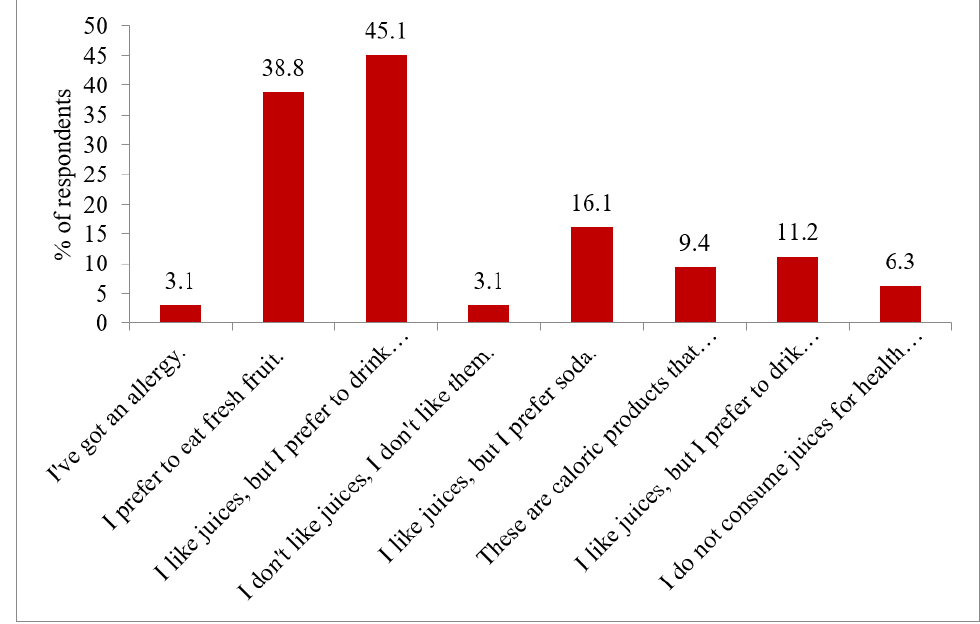
Figure 2. Reasons for infrequent consumption of citrus fruit juices by respondents.